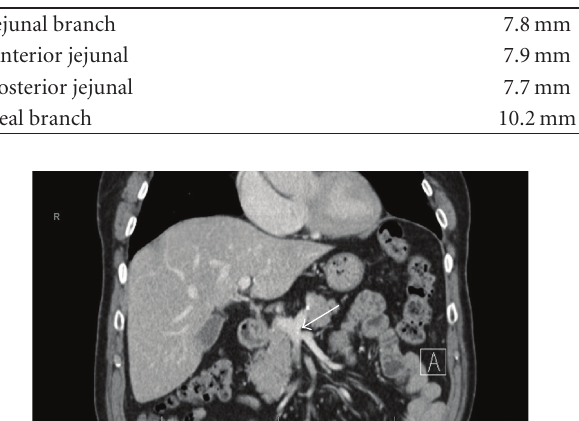
Table 2: Mean vein diameter.